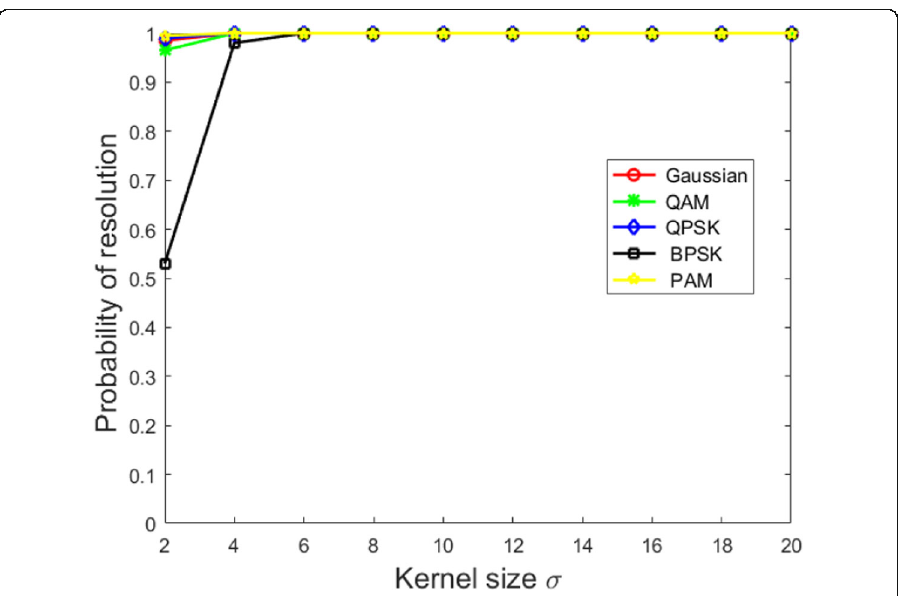
Fig. 8 Probability of resolution against kernel size σ